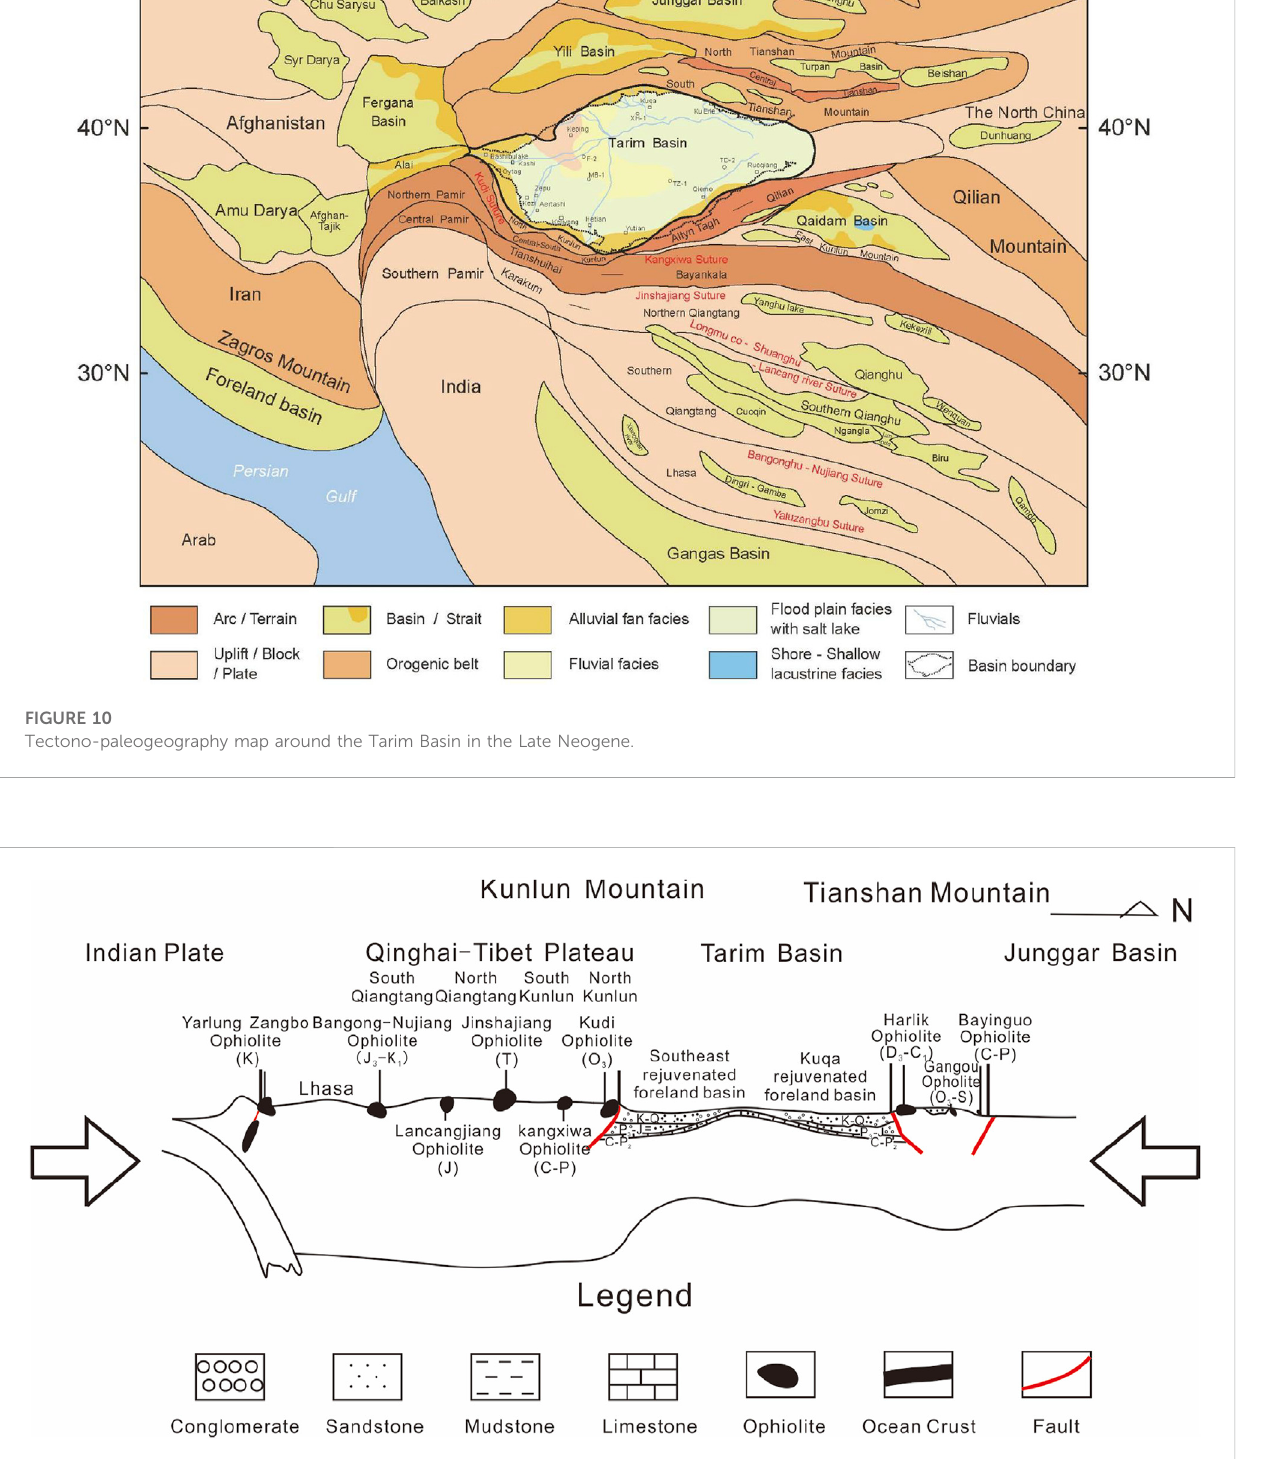
FIGURE 11 Tectonic evolution of the Tarim Basin from the Late Cretaceous to Cenozoic and its response to adjacent blocks and ocean evolution.